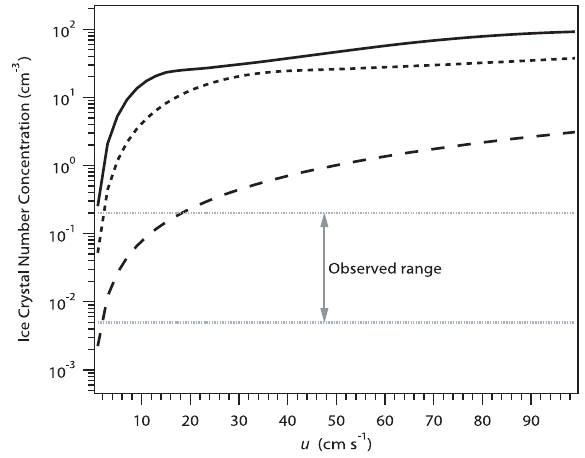
Fig. 1. Ice crystal concentration, N c , as a function of updraft velocity, u . The cloud was assumed to form at T = 185K and p = 100hPa (details provided in Sect. 3.3.1). Low values of u cor- respond to cloud formation driven primarily by large scale dynam- ics, whereas u > 50cms − 1 is characteristic of cirrus developing in the vicinity of convective systems with intense gravity wave break- ing (Kim et al., 2003). Solid line indicate N c calculated for pure homogeneous freezing, dashed line for N IN = N lim , and dotted for N IN = 0 . 75 N lim . For N IN = N lim , N c lies close to the observed val- ues for u < 50cms − 1 (Kr¨amer et al., 2009) but is very sensitive to small fluctuations in N IN